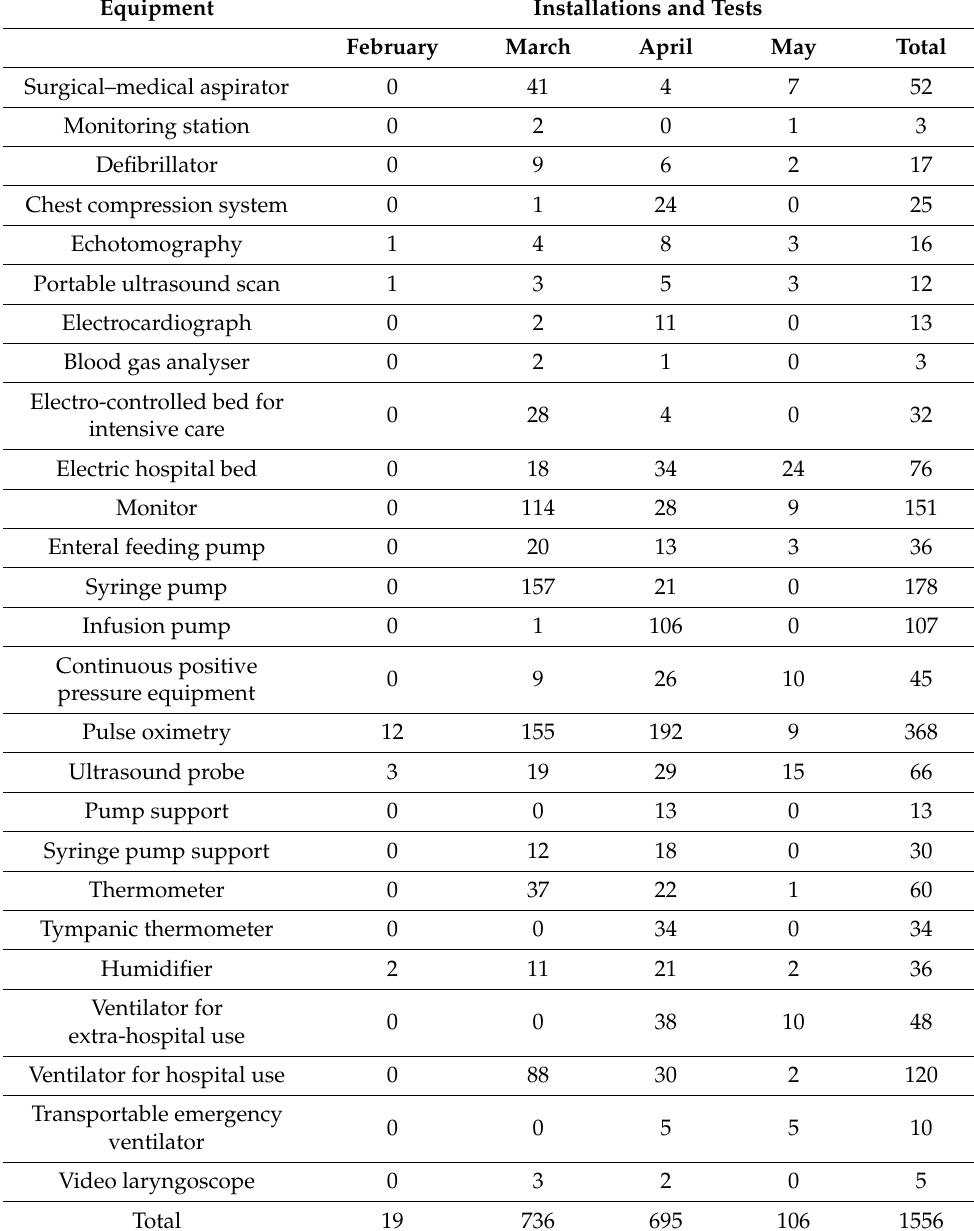
Table 13. Number of installations and tests carried out between February and May 2020.